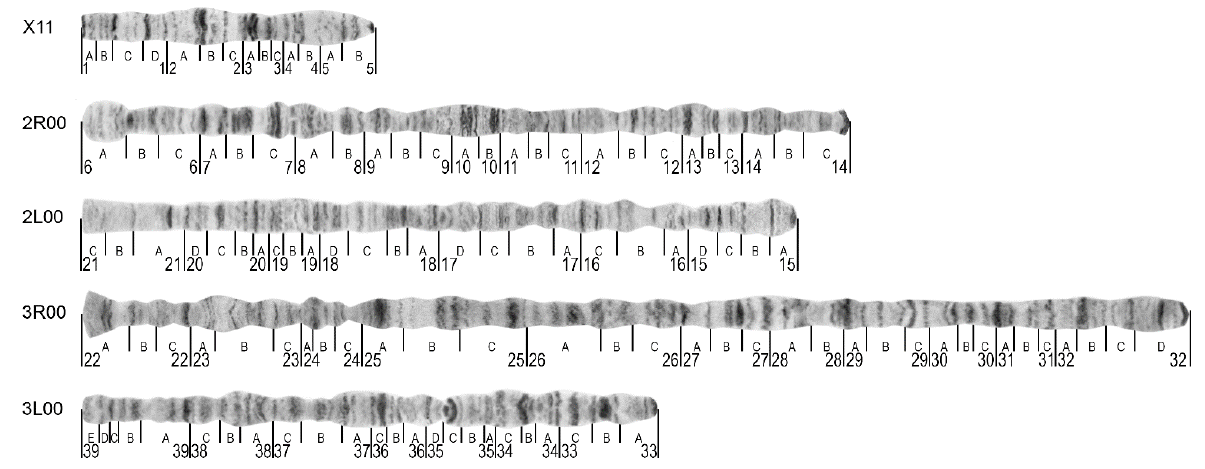
Figure 2. A standard-universal photomap for the malaria mosquitoes Anopheles messeae and Anopheles daciae. The telomere and centromere ends are shown at the left side and at the right sides of the map, respectively. Chromosome X and chromosome arms 2R, 2L, 3R, and 3L are indicated on the right. The numbered divisions (1–39) and lettered subdivisions (A–E) are shown below the chromosomes.